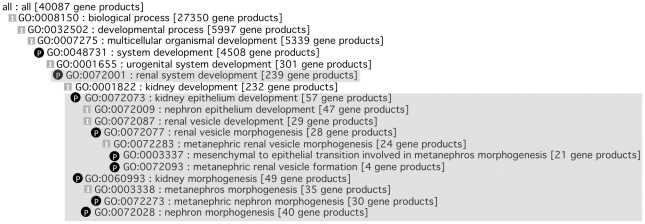
AmiGO ‘Tree View’ image of part of the kidney developmental process ontology.The ‘tree view’ in AmiGO (http://amigo.geneontology.org) showing the GO term parents of GO:0003337 ‘mesenchymal to epithelial transition involved in metanephros morphogenesis’. The most specific twelve GO terms (shaded) were amongst the 470 new terms created following the kidney development ontology workshop. The numbers in brackets indicate the number of human proteins annotated to the GO term, or one of its child terms (07th October 2011). [I] is_a parent-child relationship, ‘P’ part_of parent-child relationship.